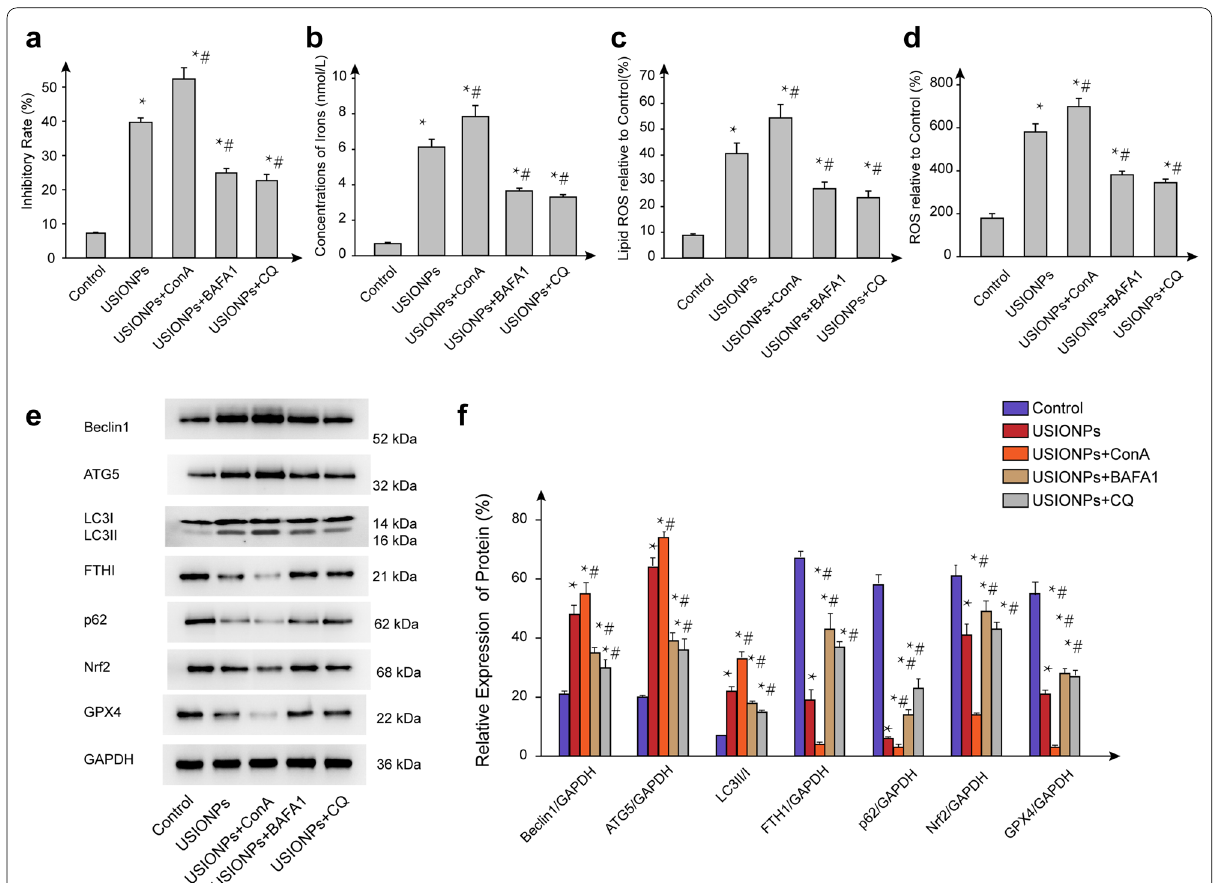
Fig. 8 USIONPs-induced ferroptosis influenced by lysosome inhibitors for 48 h. a Inhibitory rates of U251 cells in exposure to USIONPs with or without lysosome inhibitors (ConA, BAFA1, and CQ); b Concentrations of iron in the U251 cells in exposure to USIONPs with or without lysosome inhibitors; c Relative levels of lipid ROS in the U251 cells in exposure to USIONPs with or without lysosome inhibitors; d Relative levels of ROS in the U251 cells in exposure to USIONPs with or without lysosome inhibitors; e Representative images of expression of autophagy and ferroptosis related proteins in the U251 cells in exposure to USIONPs with or without lysosome inhibitors; f Relative expression of autophagy and ferroptosis related proteins in the U251 cells in exposure to USIONPs with or without lysosome inhibitors.* P < 0.05, statistically significant compared with control group. # P < 0.05, statistically significant compared with 200 μg/mL